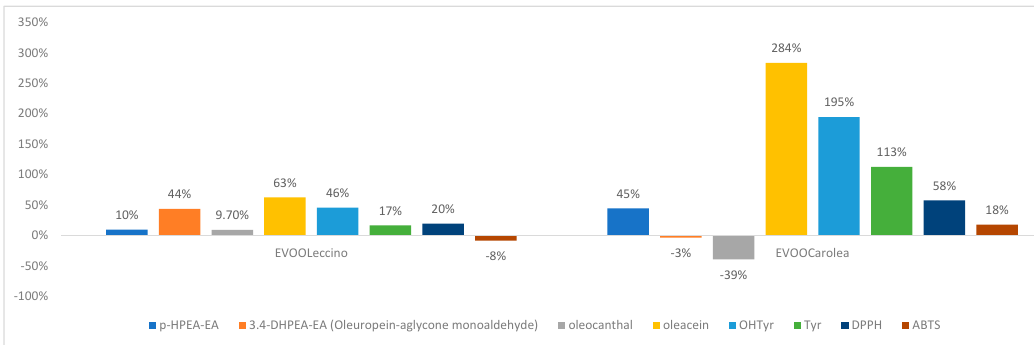
Figure 4. Variation (%) of the most representative secoiridoids, their degradation products, and antioxidant activity in EVOOs obtained from olive tree treated with T22 strains.